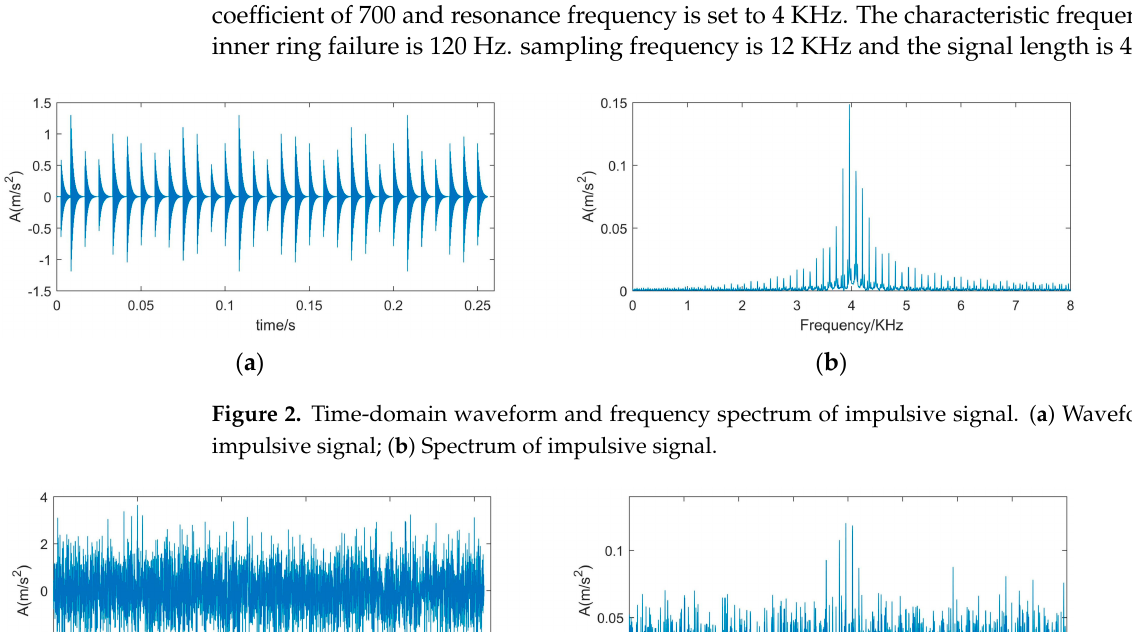
Figure 2. Time-domain waveform and frequency spectrum of impulsive signal. ( a ) Waveform of impulsive signal; ( b ) Spectrum of impulsive signal.